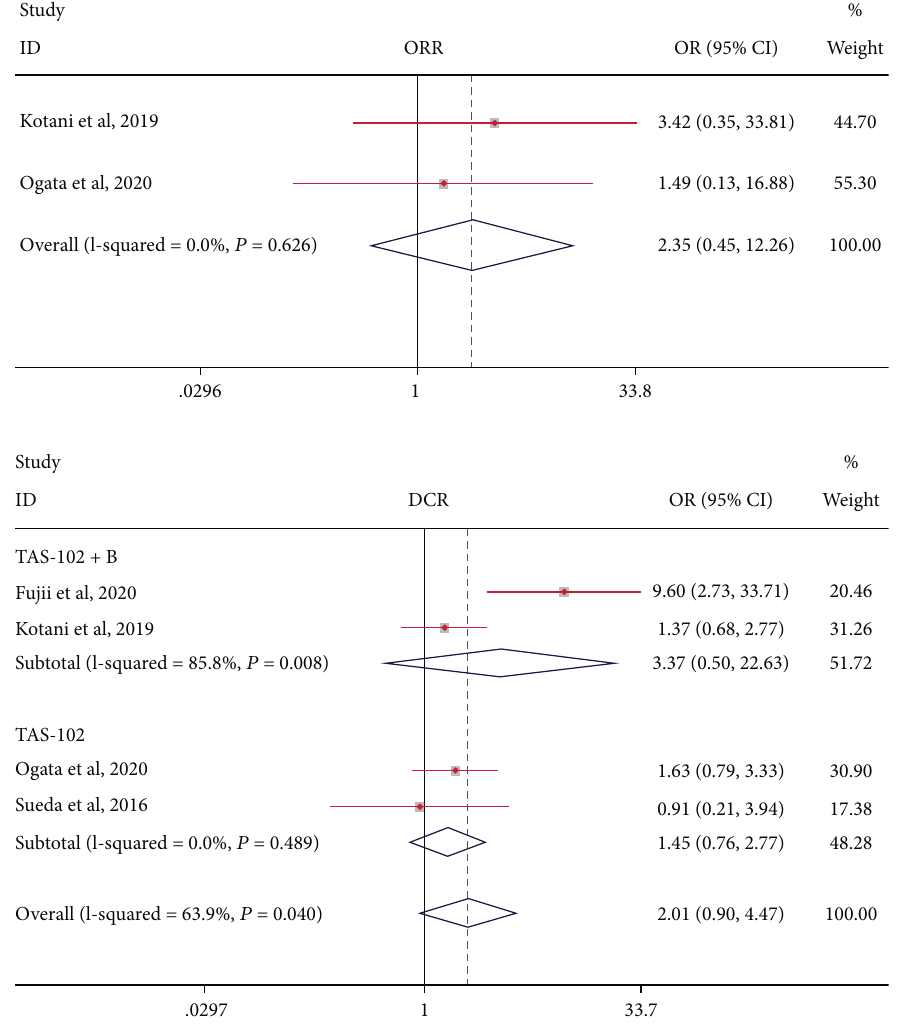
Figure 3: Objective response rate (ORR) and disease control rate (DCR) of those treated with TAS-102 monotherapy or combination therapy with bevacizumab for metastatic colorectal